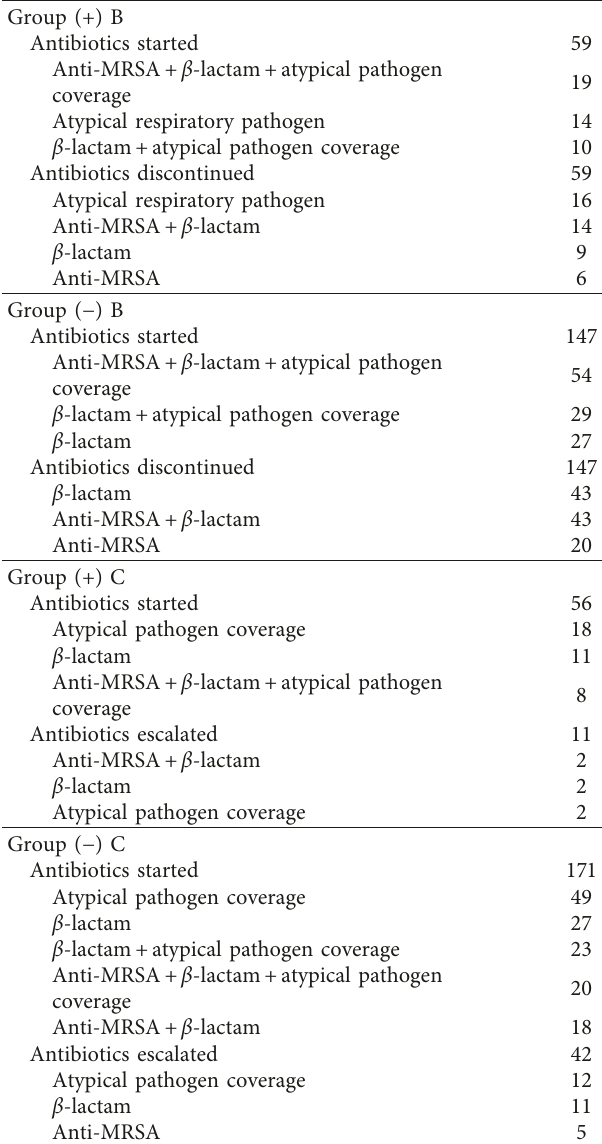
Table 2: Common antimicrobial regimens utilized to initiate (groups B and C), discontinue (group B), or escalate (group C) therapy in patients with positive (+) or negative ( − )